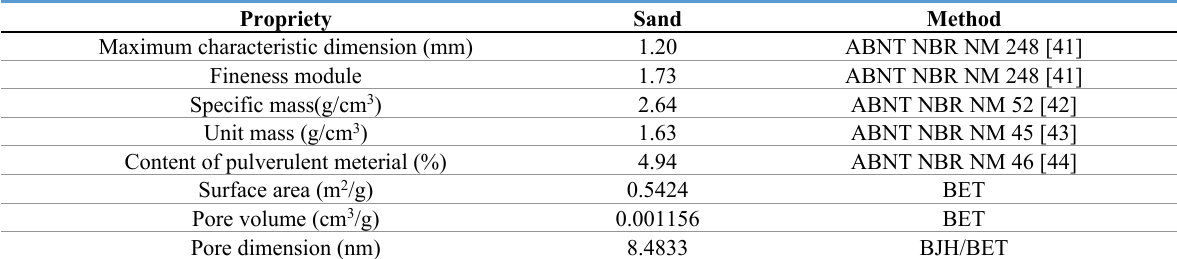
Table 3. Properties of the small aggregate.